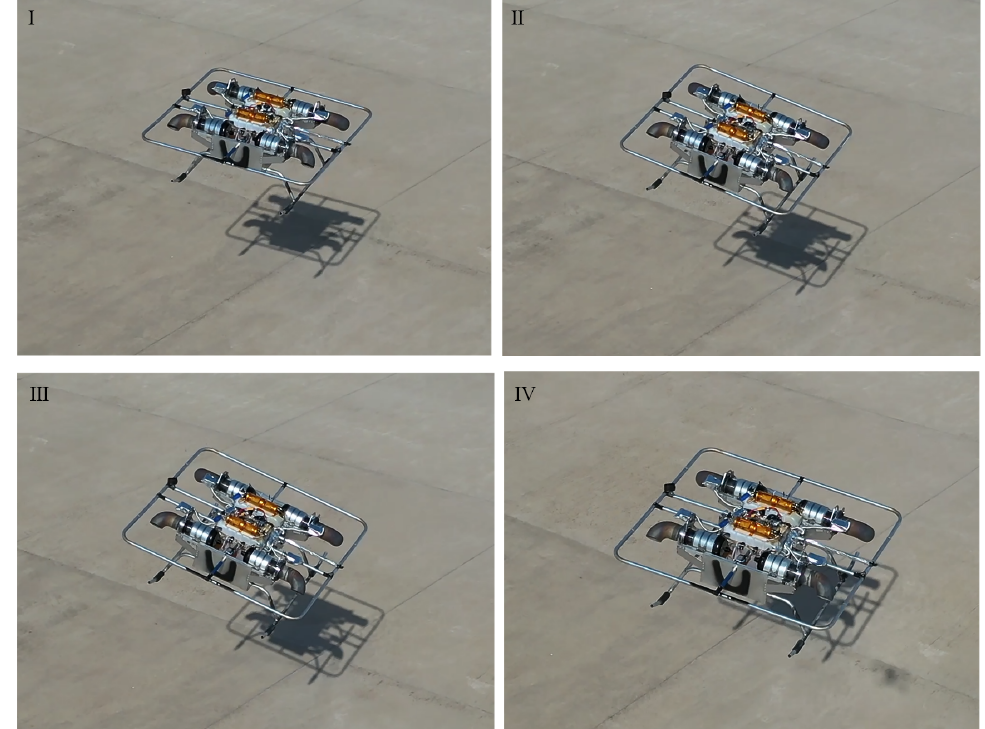
Figure 16. Change in the attitude of the aircraft during the tuning